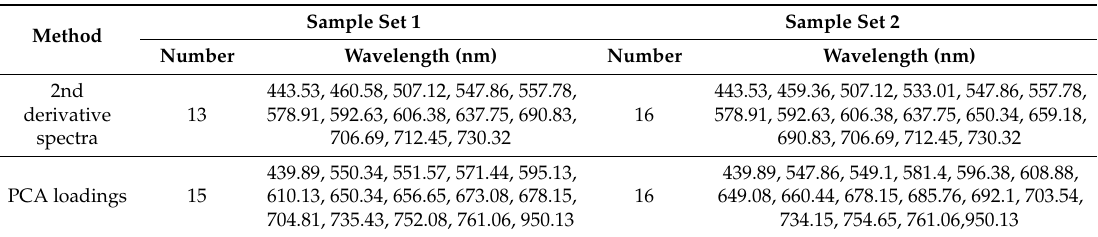
Figure 2. Optimal wavelength selection of sample set 1 and 2 by 2nd derivative spectra ( a , b ) and the PCA loadings ( c , d ). Table 2. Optimal wavelengths selection of sample set 1 and 2 selected by 2nd derivative spectra and the PCA loadings of sample set 1 and 2 using sample average spectra.